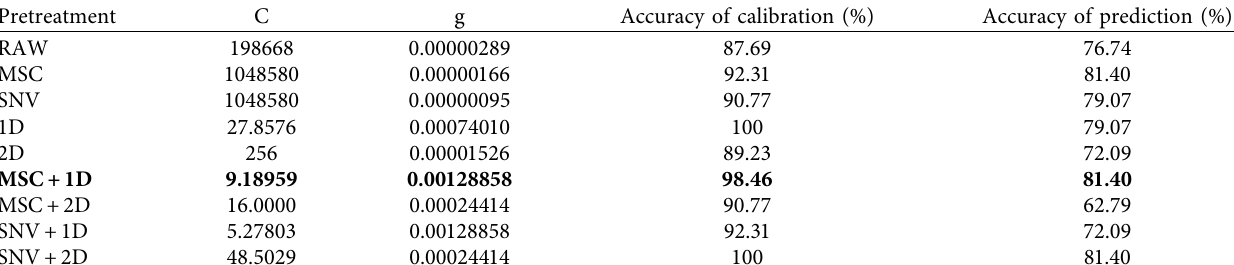
Table 1: The influence of pretreatment on SVM model.